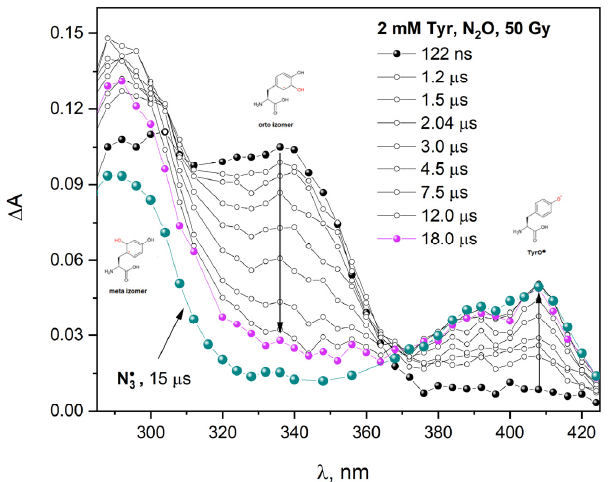
Figure 10. Transient absorption spectra of N 2 O-saturated buffer solution containing 2 mM